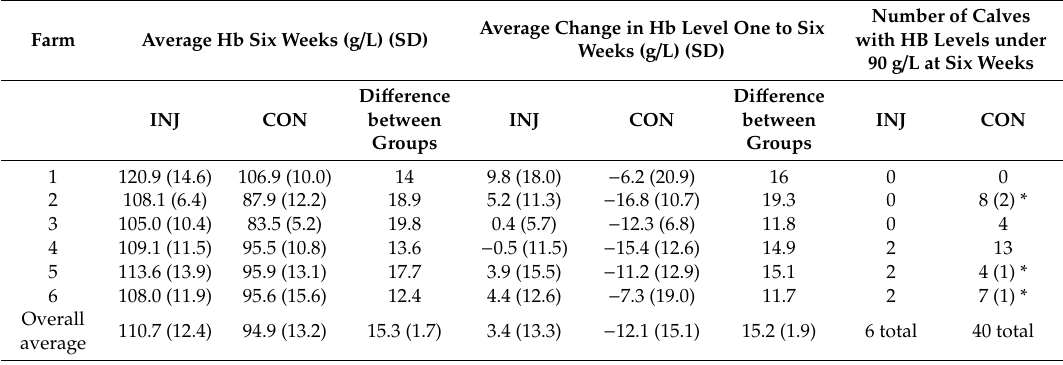
* Calves under 72.5 g /